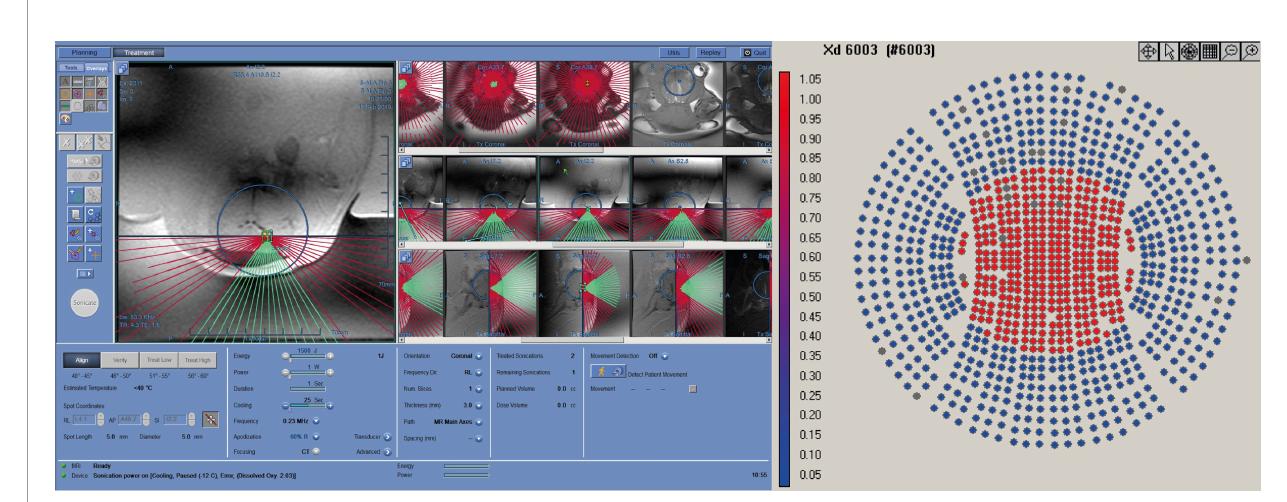
FIGURE 2 | T1- and T2-weighted images acquired after the sonication procedure.